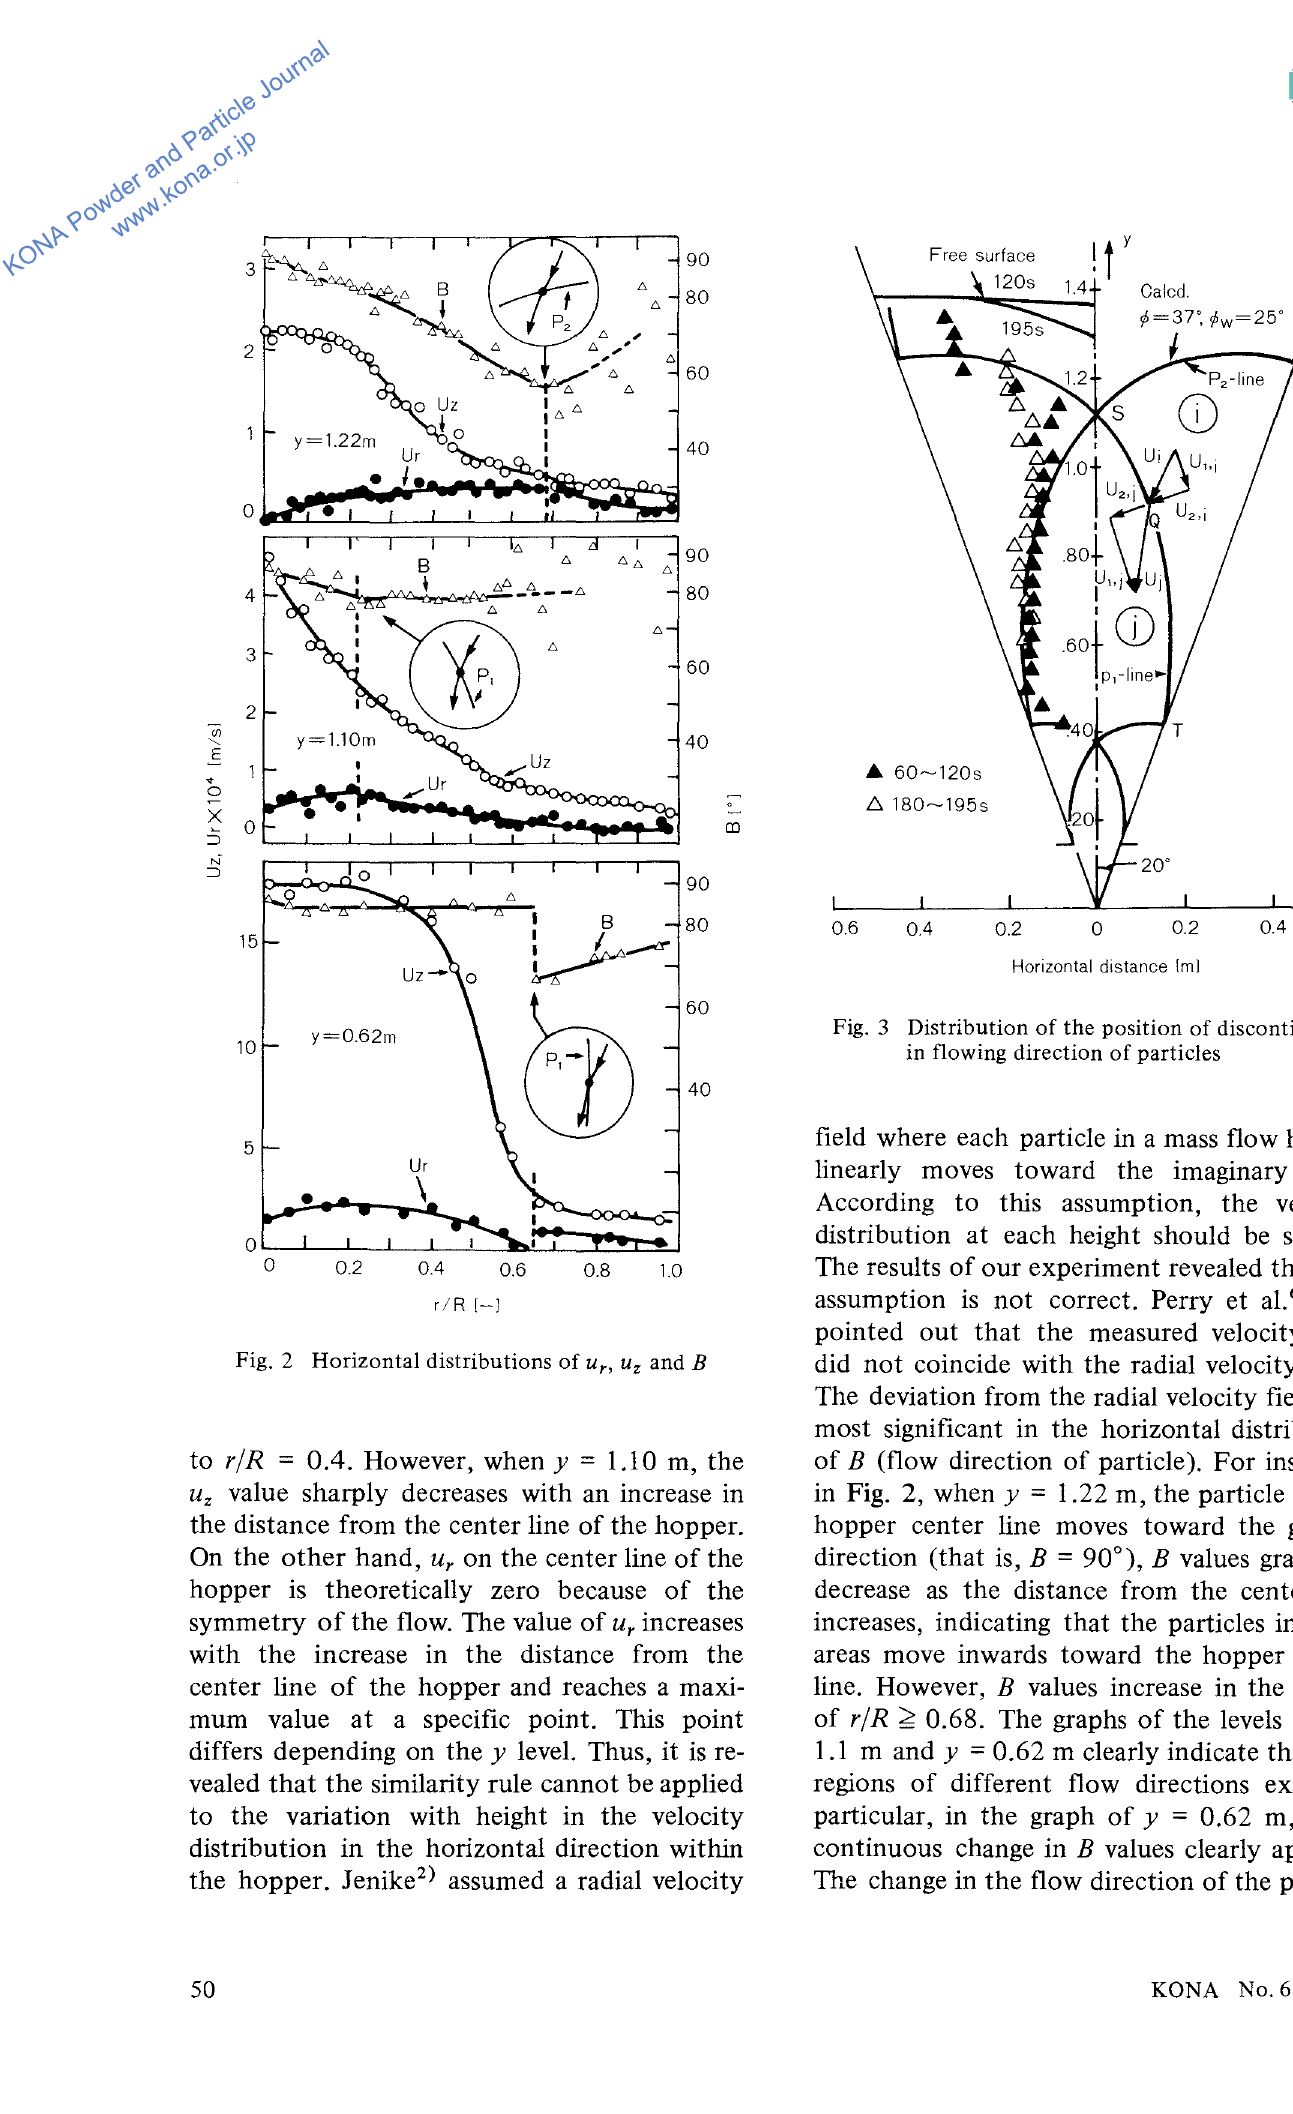
Fig. 2 Horizontal distributions of uy, Uz and B